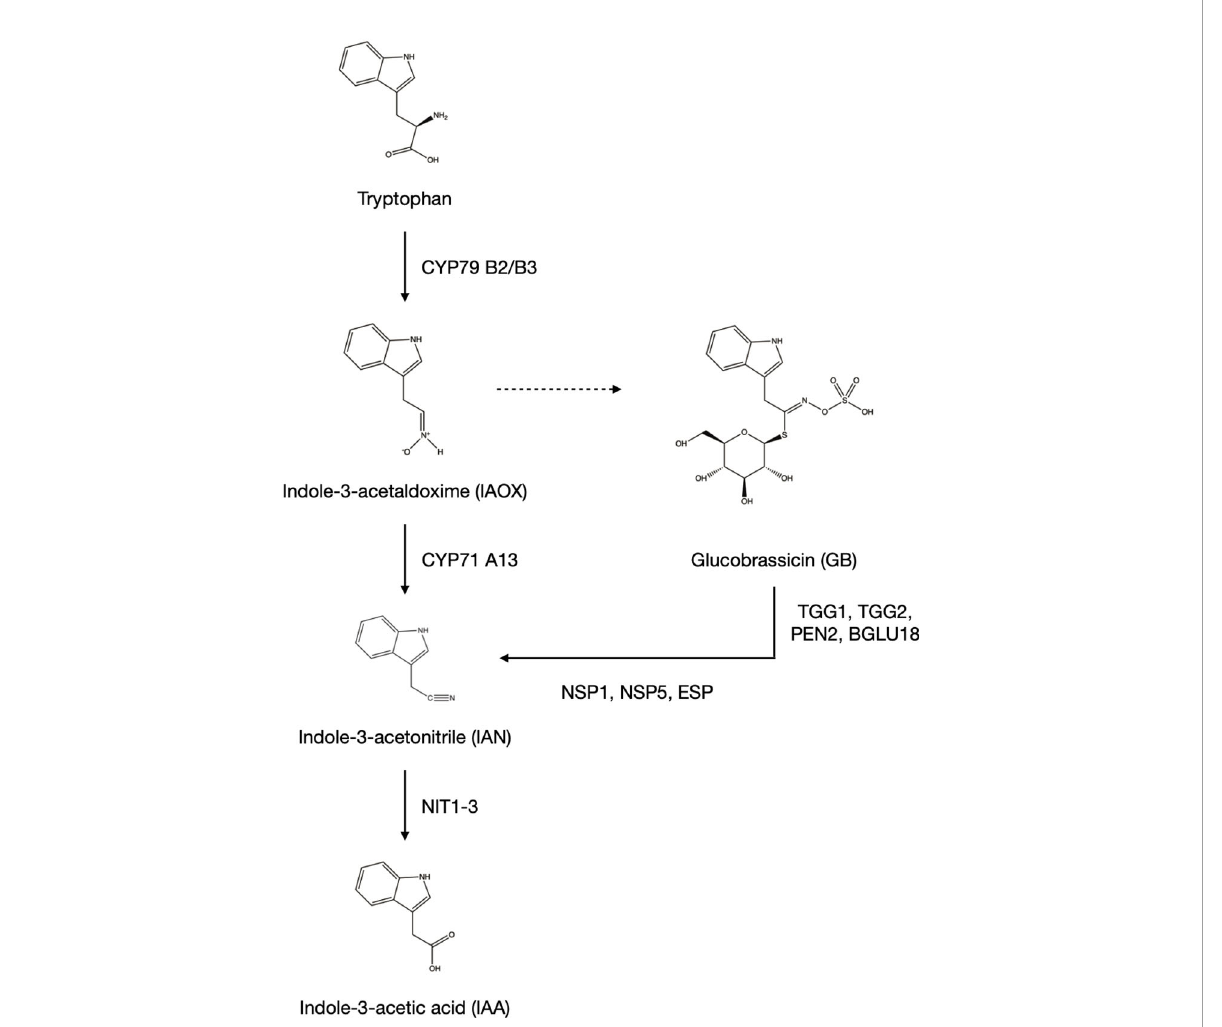
FIGURE 1 Synthesis of indole-3-acetic acid (IAA) in Arabidopsis thaliana. Members of the Brassicaceae family are able to synthesize IAA through additional synthetic pathways starting from indole-3-acetaldoxime (IAOX). IAA is synthesized from the common intermediate indole-3-acetonitrile (IAN), either coming directly from indole-3-acetaldoxime (IAOX), or the breakdown of the indolic glucosinolate glucobrassicin (GB). The dotted line from IAOX to GB indicates multiple steps. The fi gure was created using ChemDraw Professional Version 20.0.0.38 (PerkinElmer, Waltham, United